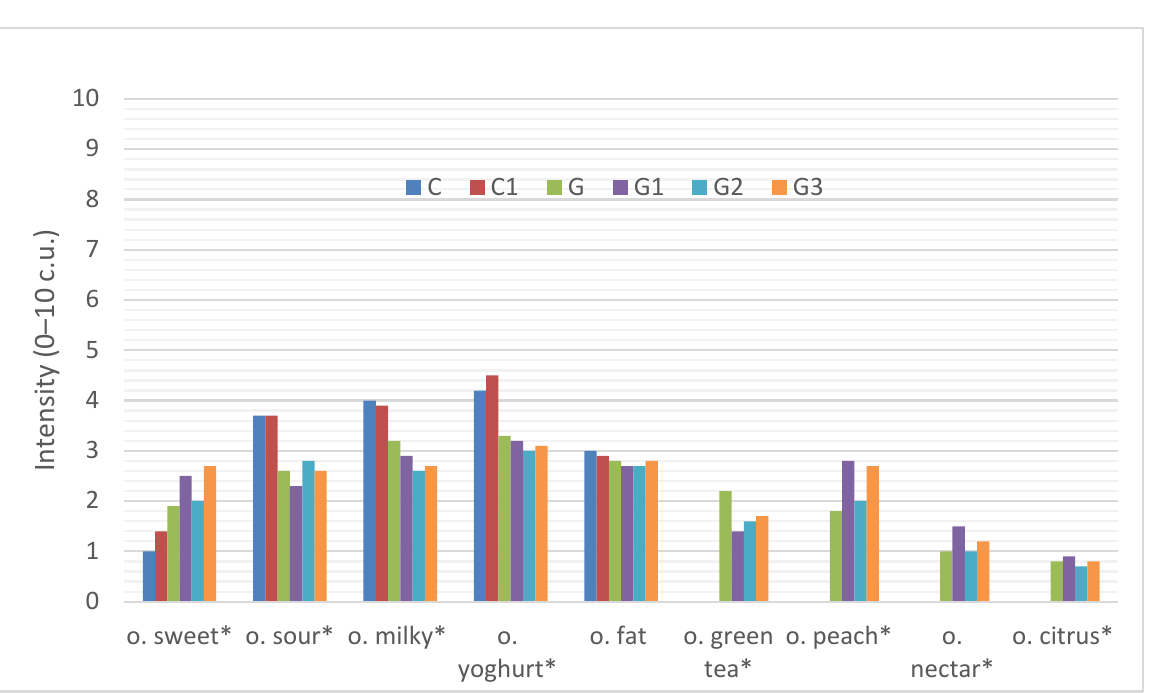
Figure 1. Sensory profile of the odor of yoghurts C, C1, G, G1, G2. The abbreviations in the figure refer to the control sample (C), control yoghurt with 6% inulin (C1), yoghurt with green tea (G), yoghurt with green tea and 3% inulin (G1), yoghurt with green tea and 6% inulin (G2), yoghurt with green tea and 9% inulin (G3) (o- odor; * significantly differed at p ≤ 0.05). We can note that the addition of inulin and the use of infused green tea in the yoghurt production process significantly influenced the aroma profile of the yoghurts. The